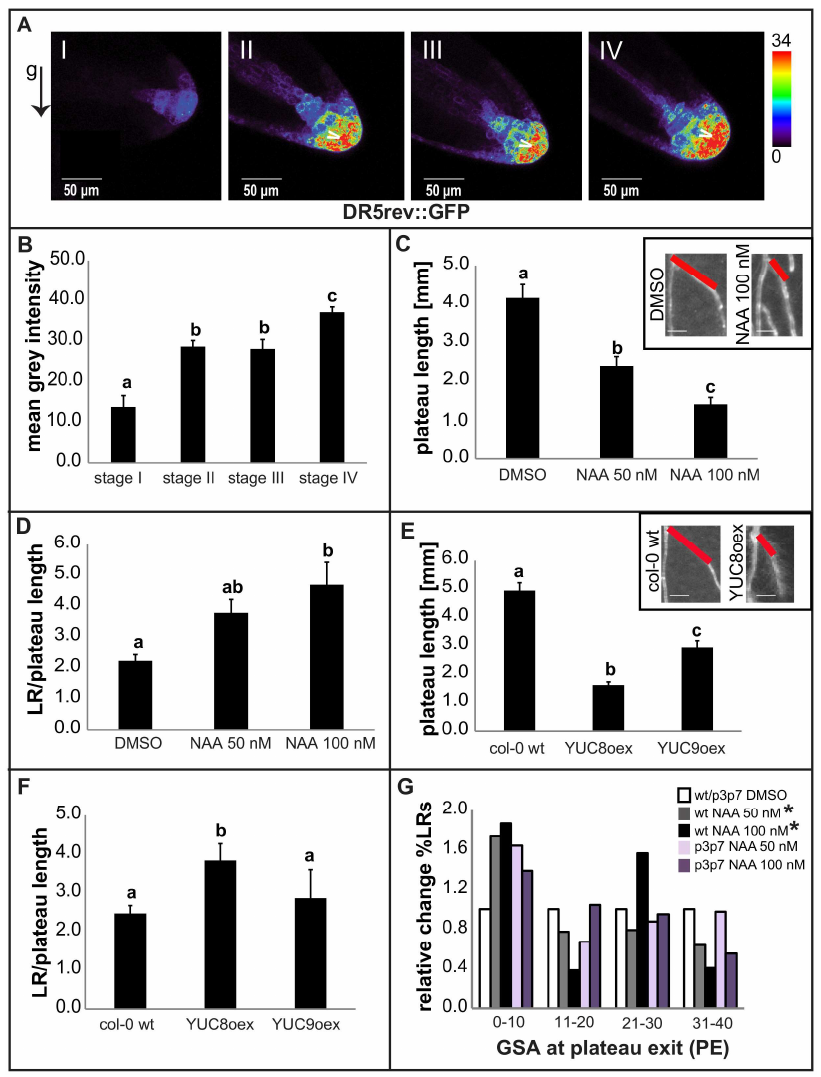
Figure 3. Auxin induces termination of the plateau phase. ( A , B ) Increases in auxin signaling at the root tip, visualized by DR5 (Direct Repeat 5) promoter-driven GFP (Green Fluorescent Protein) signal ( A ), accompany the transitions from stage I to II and from stage III to IV during LR development. Arrowheads denote areas of high DR5 activity. A semiquantitative color-coded heatmap of the